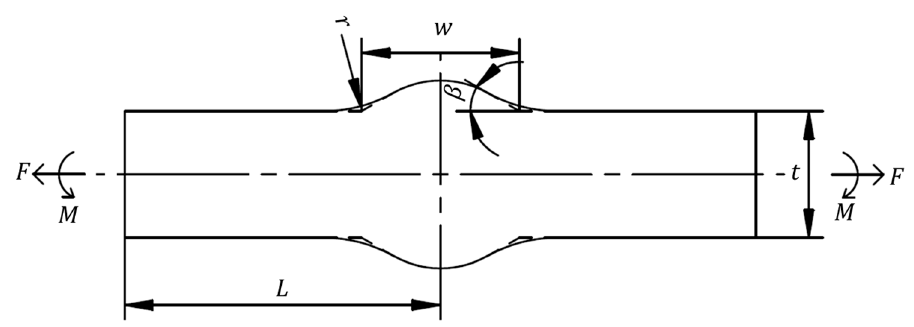
Figure 1. Butt joint geometry and loading conditions.